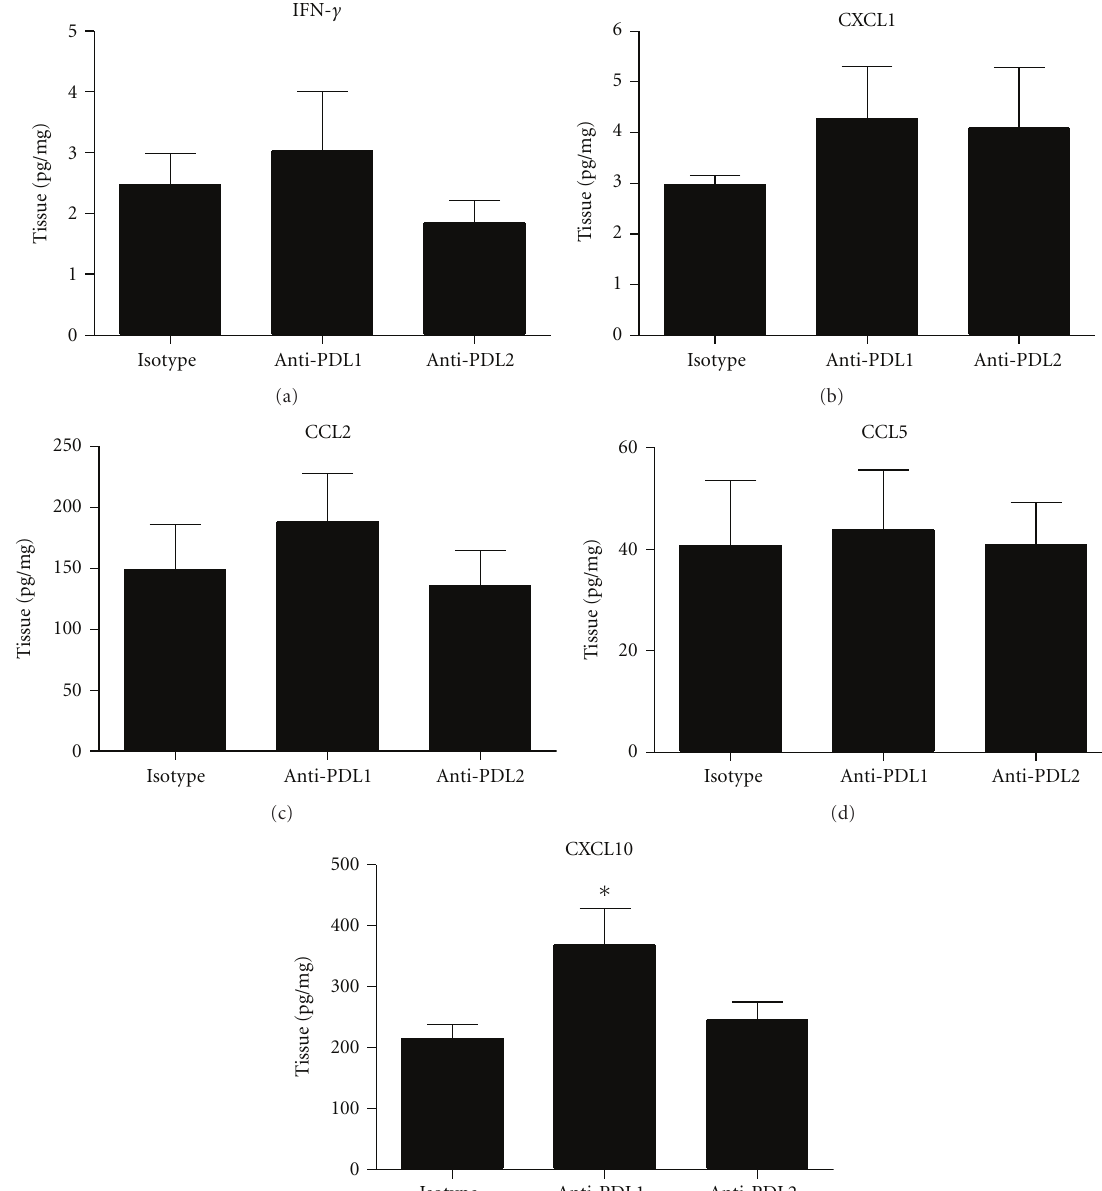
Figure 4: Cytokine expression following HSV-1 infection and treatment with anti-PD-L1 or anti-PD-L2 antibody. C57BL/6 mice were infected with 1,000 PFU HSV-1/cornea. At days 2, 4, and 6 p.i. mice were administered neutralizing antibody to PD-L1, PD-L2, or control IgG. At day 7 p.i. mice were exsanguinated and the TG was processed for suspension array or ELISA. (a) IFN- γ levels. (b) CXCL1 levels. (c) CCL2 levels. (d) CCL5 levels. (e) CXCL10 levels. Cytokine levels are a summary of two to three experiments ( n = 6–9). Each bar